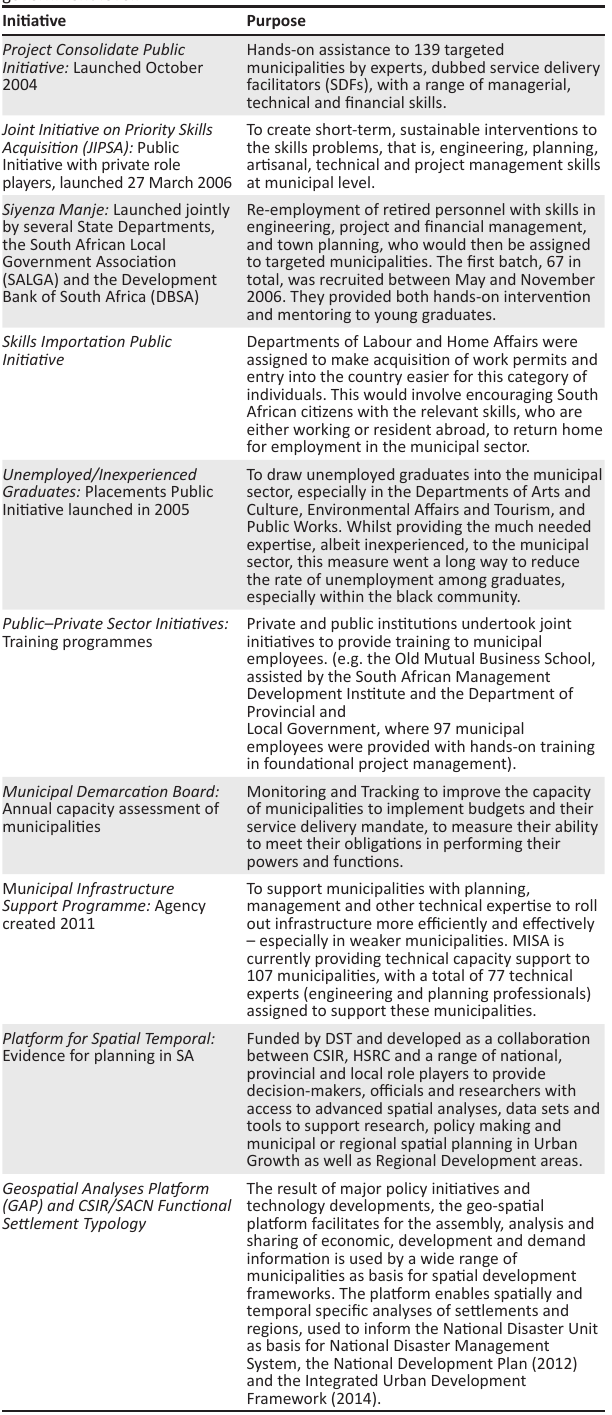
TABLE 2: Public and private sector initiatives to build capacity at local government level.